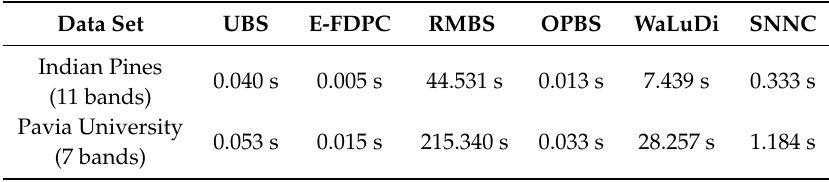
Table 4. Processing time of different methods on two data